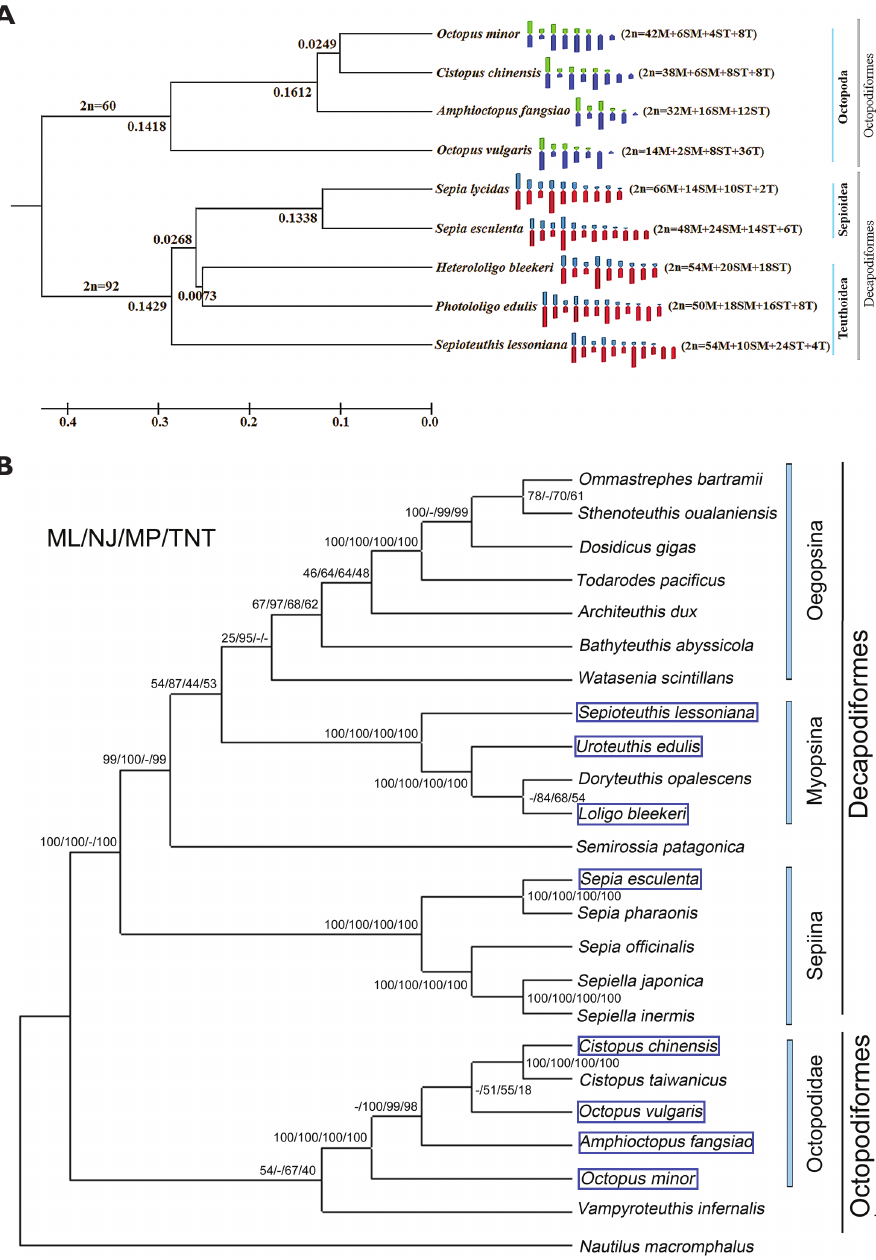
Figure 3. A Relationships between chromosome number and UPGMA clustering of nine species of cephalopods by evolutionary distance with simplified karyo-idiogram and karyotype formulas. Chromo- some numbers and D values are shown on the corresponding branches B Phylogenetic relationships e among the cephalopods based on mitochondrial DNA sequences including the nine species of this study (Cheng et al.